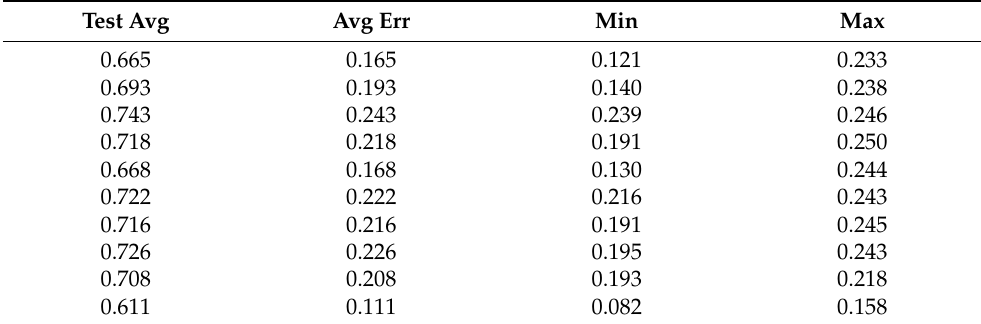
Table A23. Set 1, trials 11–20 data (all 0.5 PR values).